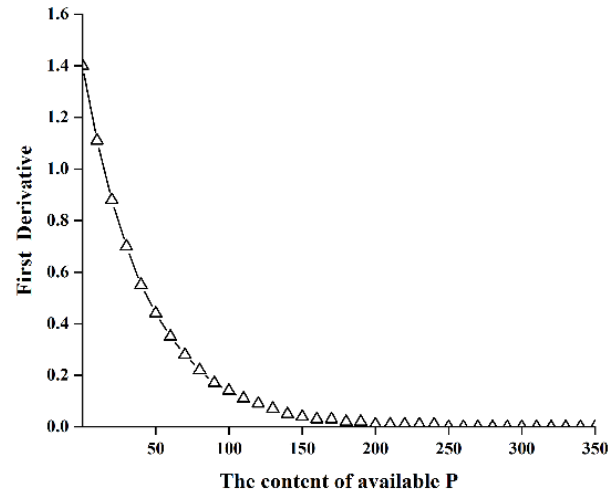
Figure 3. The first-order derivative of the equation modeling the change in the fresh weight of spinach with increasing soil available phosphorus.